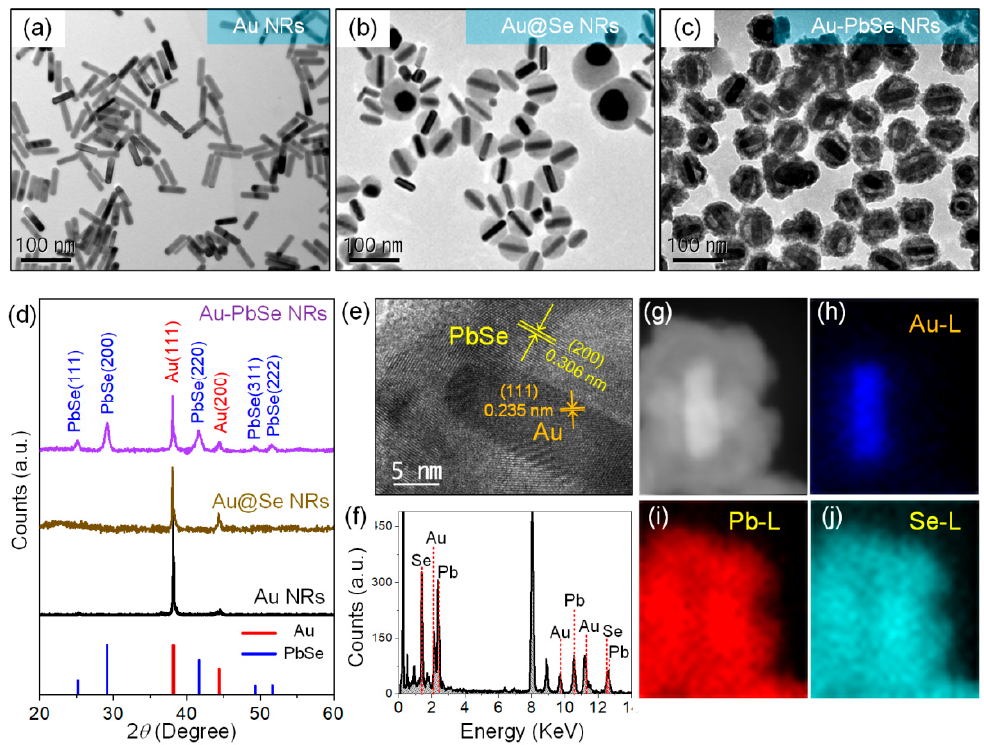
Figure 2. Transmission electron microscopy (TEM) images of ( a ) initial Au NRs; ( b ) Au@Se NRs; ( c ) Au–PbSe yolk-shell NRs; ( d ) X-ray diffraction (XRD) spectra of the samples obtained at different reaction stages; ( e ) high-resolution TEM (HRTEM) image; ( f ) the corresponding energy dispersive